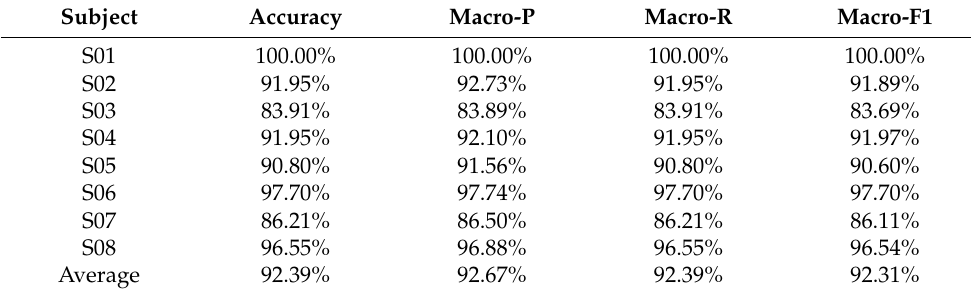
Table 2. Classification Evaluation Metrics.